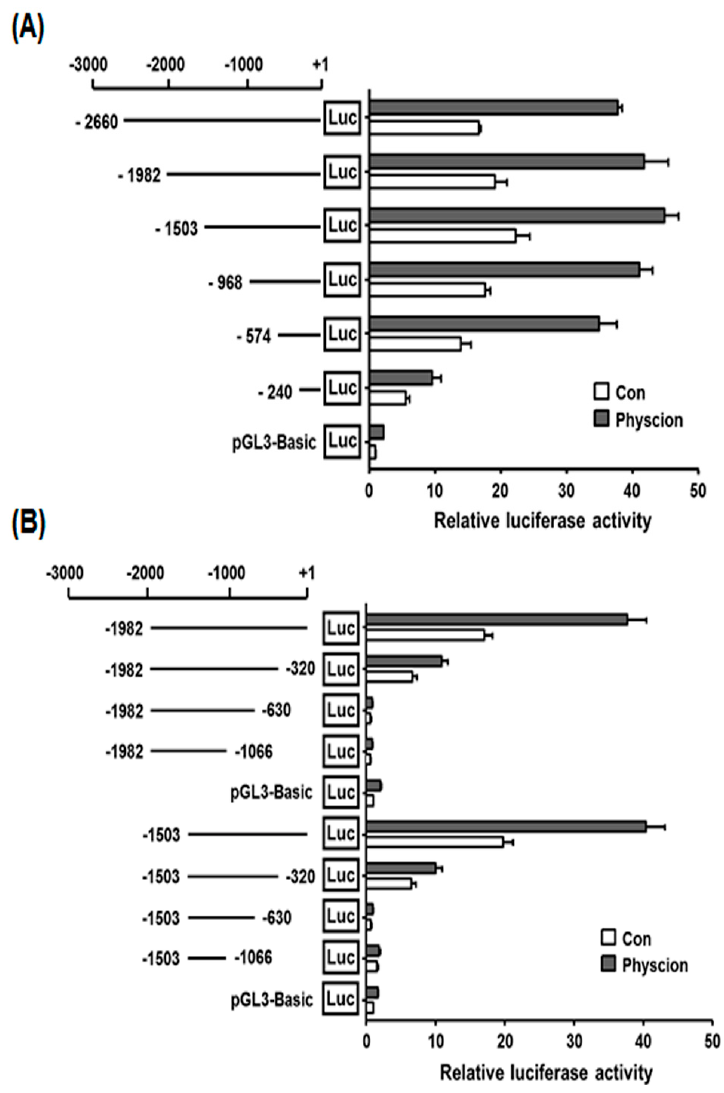
Figure 4. Deletion analysis of hST8Sia VI promoter in SK-N-BE(2)-C cells with physcion treatment. Reporter plasmids contain progressive deletions from the 5 ′ end ( A ) and the 3 ′ end ( B ) of the hST8Sia VI gene promoter. After co-transfection of each construct into SK-N-BE(2)-C cells with pRL-TK, relative firefly luciferase (Luc) activity was assessed. The pRL-TK-derived Renilla luciferase activity was used to normalize all firefly luciferase activity. Data are the means ± SD of triplicate measurements and are representative of three independent experiments.